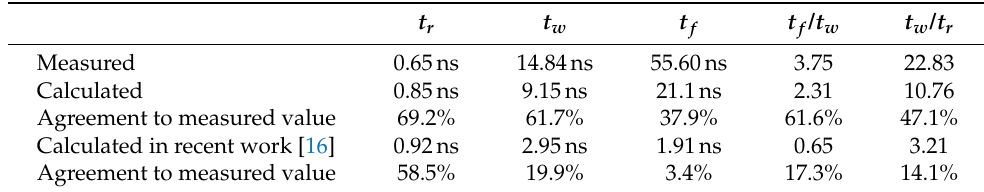
Table 2. Pulse shape parameters of the measured and calculated discharge current and their agreement.